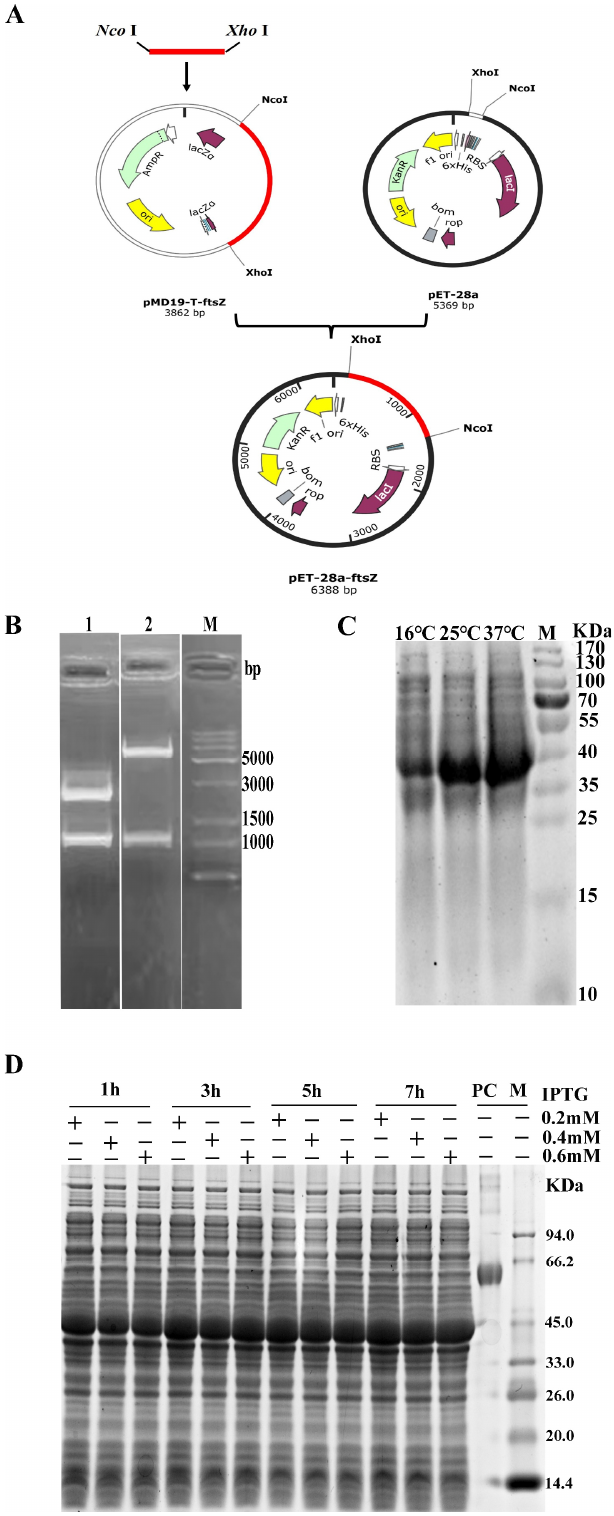
Figure 1. Construction of recombinant plasmids and FtsZ protein expressed in E. coli under different conditions. ( A ) Construction of recombinant plasmids. ( B ) Digestion of recombinant plasmids with endonucleases. Lane 1: digestion of pMD-ftsZ plasmids with Nco I and Xho I; lane 2: digestion of pET-28a-ftsZ plasmids with Nco I and Xho I. M: marker. ( C ) Expression of FtsZ at different temperatures. M: marker. ( D ) Different induction times (1, 3, 5, and 7 h) and IPTG concentrations ranging from 0.2 to 0.6 mM. PC: bovine serum albumin; M: marker.